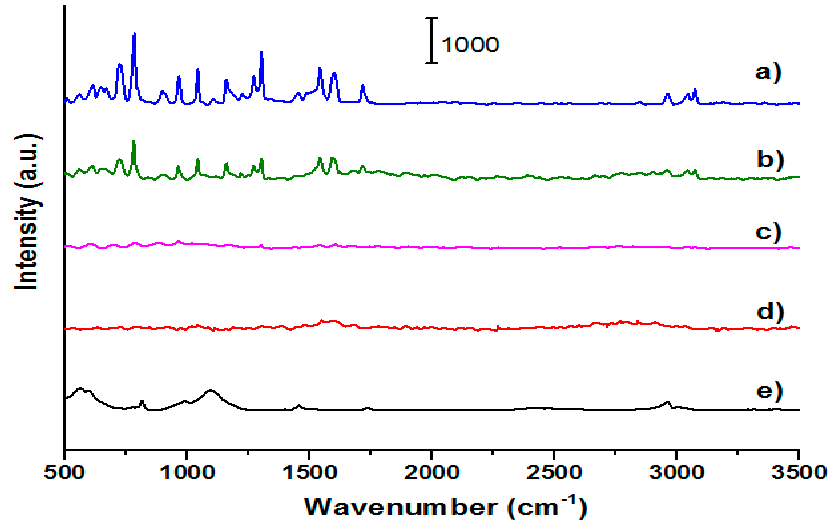
Figure 6. Raman spectra of ( a ) 0.1 M thiophanate methyl, ( b ) 10 − 4 M thiophanate methyl deposited onto AuNSps coated glass substrate, ( c ) 10 − 4 M thiophanate methyl, ( d ) AuNSps, and ( e ) glass substrate.